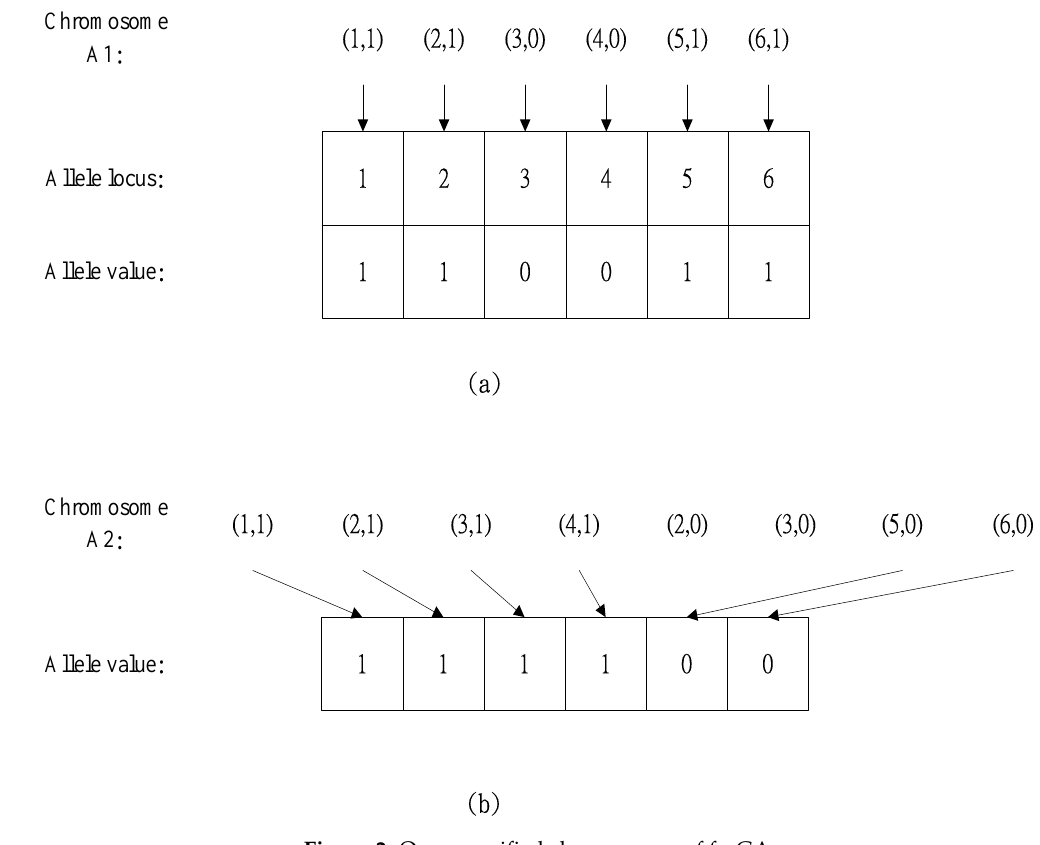
Figure 2. Over-specified chromosome of fmGA.